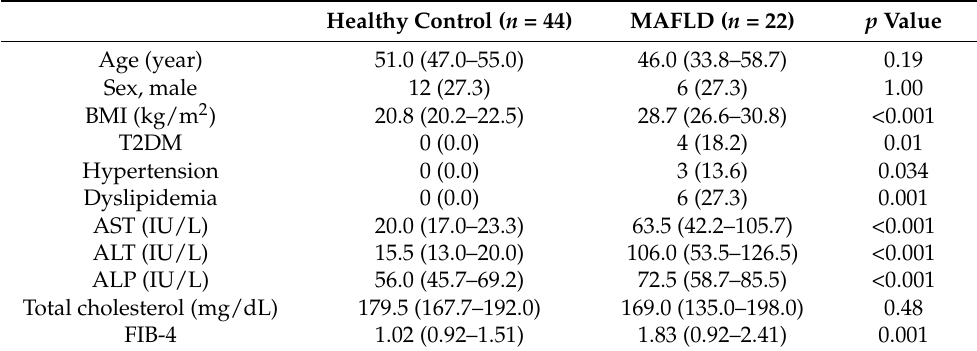
Table 1. Baseline characteristics of overall